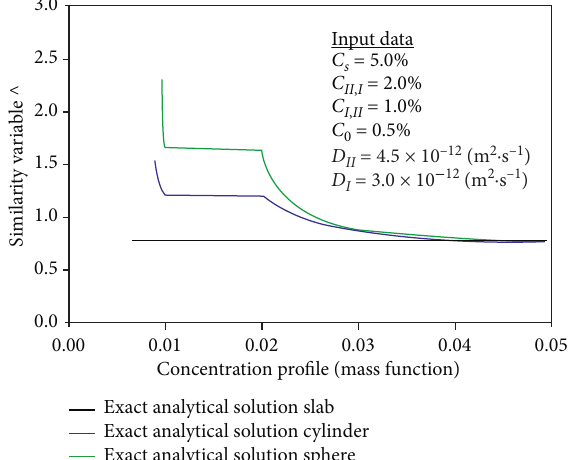
Figure 22: Comparison of similarity variables in relation to the concentration profiles during inward diffusion of a slab, a cylinder, and a . sphere at 70% of R 0